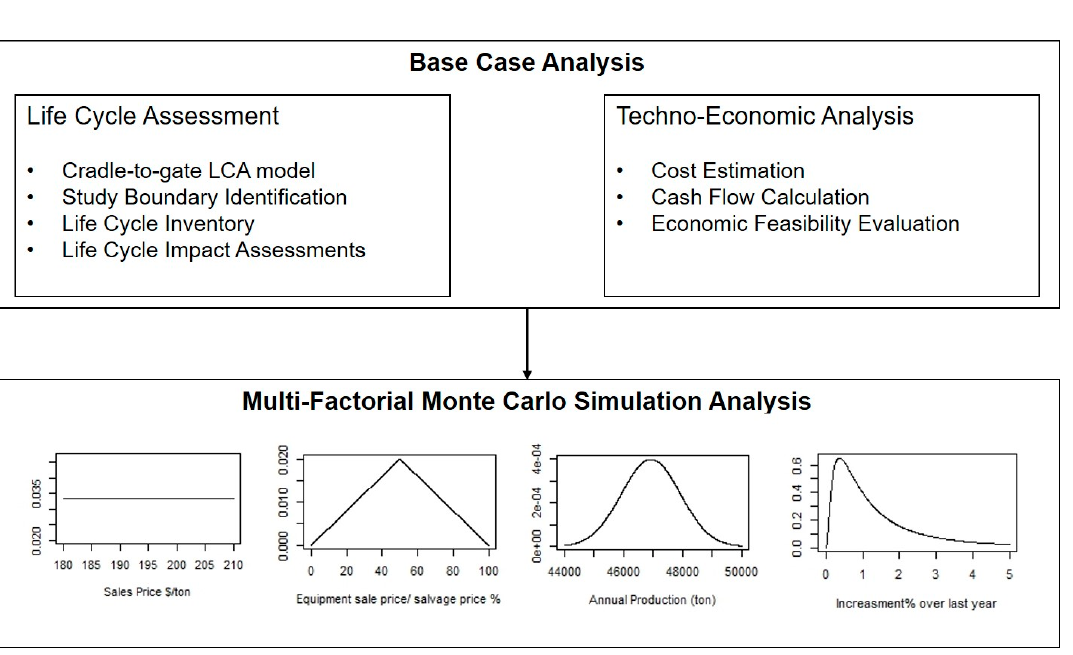
Figure 1. Flow chart of the economic and environmental impacts of biomass for bioenergy products.